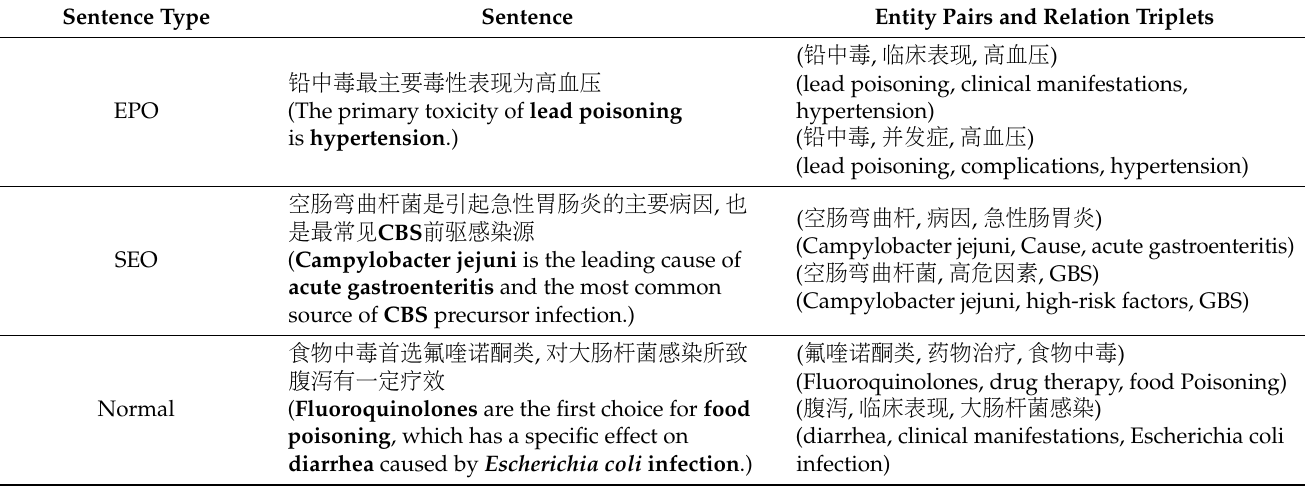
Table 1. Examples of the relations between medical